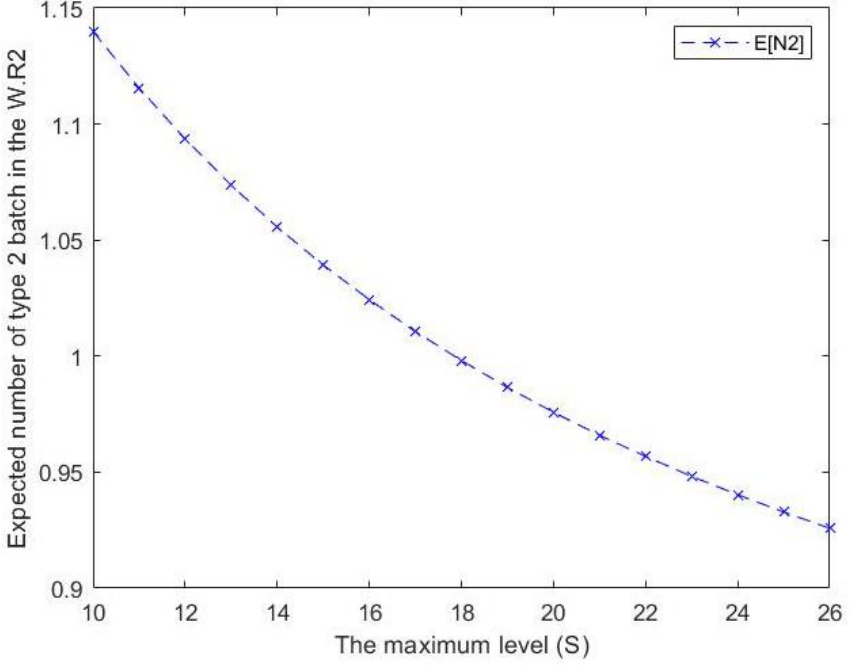
Figure 4. Effect of S on expected number of type 2 customers in the waiting room for type